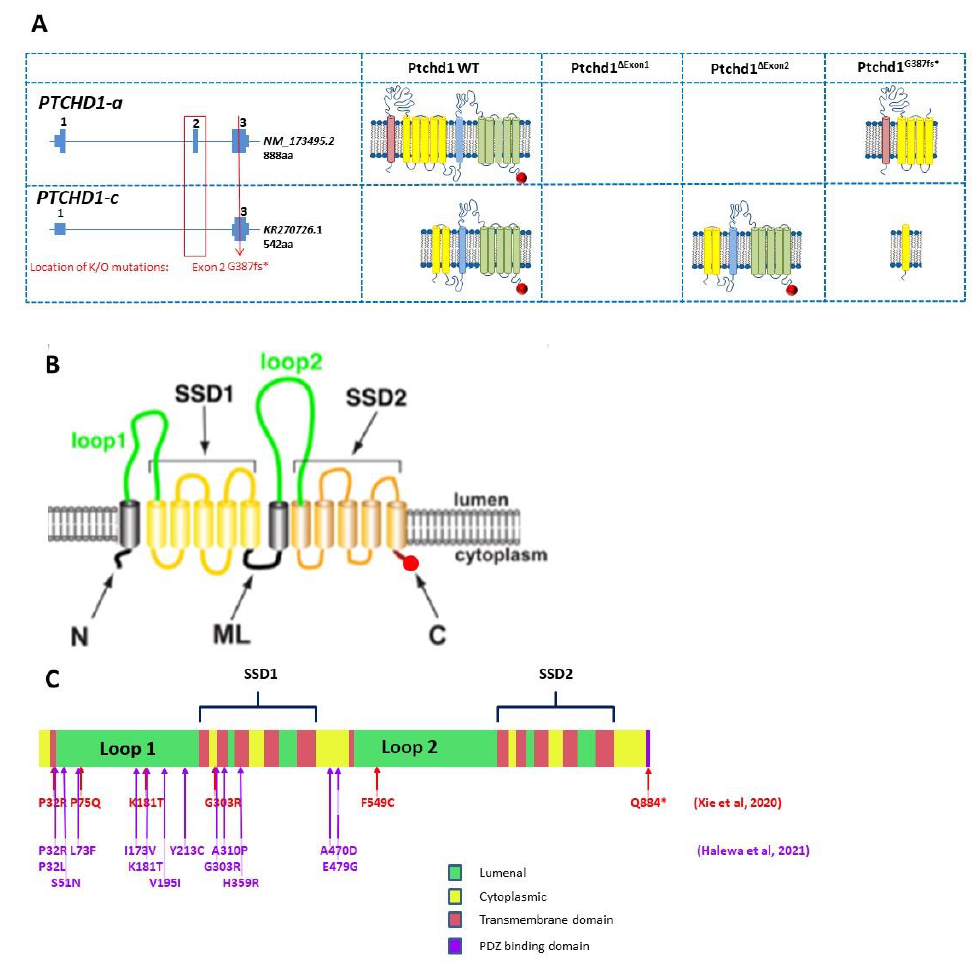
Figure 4. ( A ) Genomic organization of Ptchd1 isoforms a and c and predicted translation products resulting from the Murakami et al. [48] exon 1 knockout mice, Wells et al. [31] and Ung et al. [33] exon 2 knockout mice, and the CRISPR/cas9 knockout mouse generated by Frankland and Vincent [49]. The PDZ-binding motif is indicated by a red circle. N.B. Ptchd1-c transcription is activated (>80-fold) in the brains of the Wells et al. mice [31]. There are no predicted translation products for the exon 1 knockout [48], as the predicted promoter is also disrupted, and no additional promoters are predicted (genomatix.com, accessed on 2 August 2011). ( B ) Cartoon of PTCHD1 illustrating the predicted topological orientation of specific regions in the membrane; putative sterol-sensing domains (SSD) 1 and 2, luminal loops 1 and 2, medial loop (ML), N and C-termini, are shown. ( C ) Localization of missense variants studied in Halewa et al. [16] and Xie [37]. A more complete list of